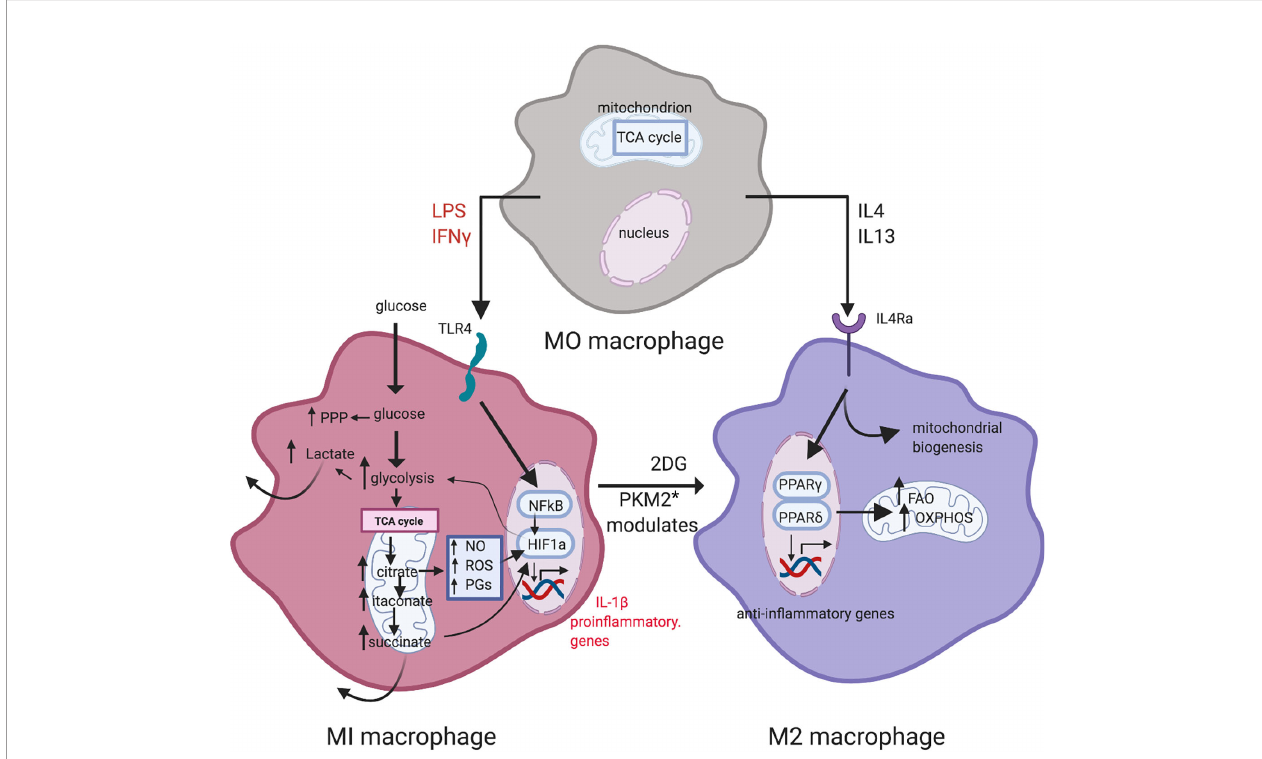
FIGURE 2 | Metabolic reprogramming in macrophage polarization. LPS and IFN- g induce M1 macrophages. Metabolism in M1 macrophages is characterized by increased glycolysis and PPP activity, and a broken TCA cycle that leads to metabolite accumulation. M2 macrophages display a more oxidative metabolic pro fi le, with a high reliance on the TCA cycle, utilizing OXPHOS and exhibiting high levels of FAO. Inhibition of glycolysis by 2-DG leads to an oxidative M2 phenotype [from Corcoran and O ’ Neill (48)]. Figure created with Biorender.com. * PKM2: pyruvate kinase